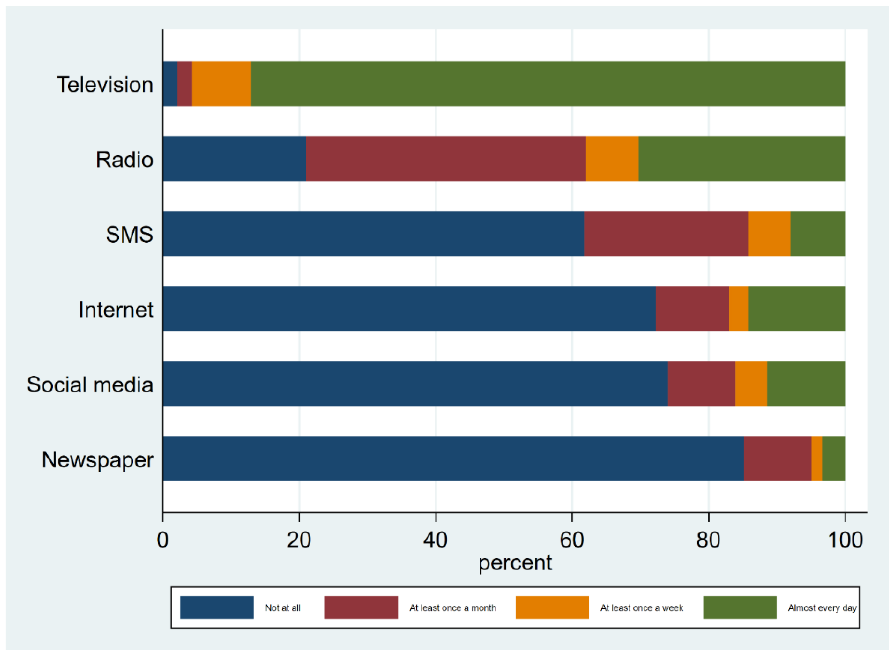
Figure 2. Frequency of media use ((SMS = Short Message Service).